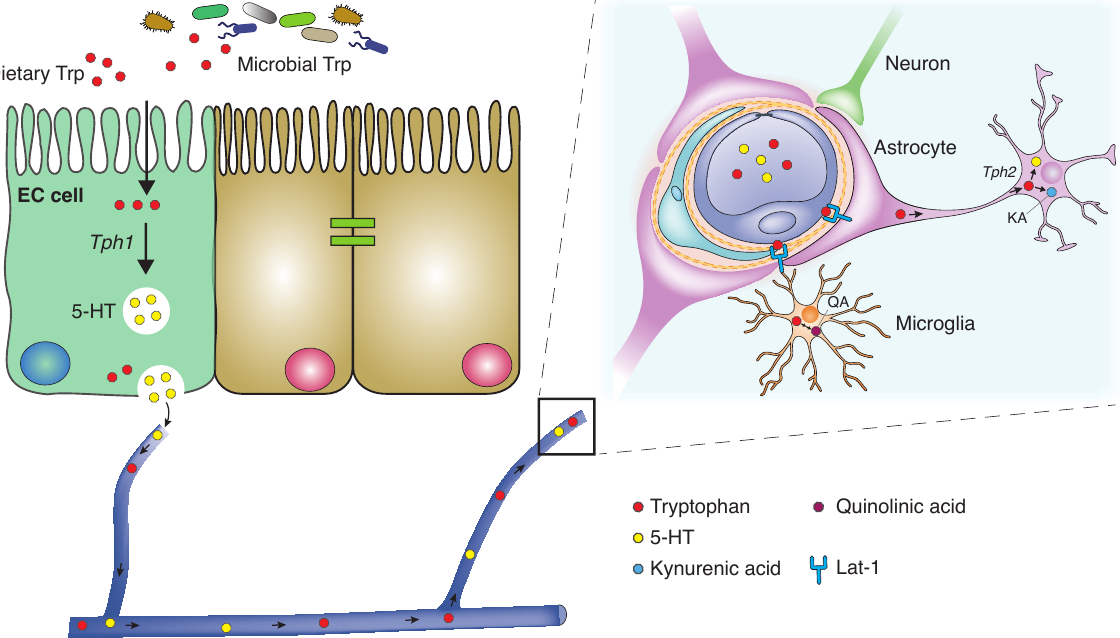
Figure 2. Tryptophan Metabolism and Transport. Dietary and microbial tryptophan (TPH) is absorbed in small intestinal epithelium. In enterochromaffin cells (ECs), TPH is released unaltered into the peripheral circulation, where it is degraded in the liver and other peripheral tissues to kynurenine and its metabolites. Or, it is converted to serotonin in ECs via tryptophan hydroxylase 1 (TPH1). TPH is transported across the blood-brain barrier (BBB) into astrocytes via Lat-1 large neutral amino acid transporter. In neurons and glia, it is converted to serotonin via TPH2, or catabolized by the kynurenine degradation pathway to kynurenic acid. Most of the brain quinolinic acid derives from TPH catabolism in